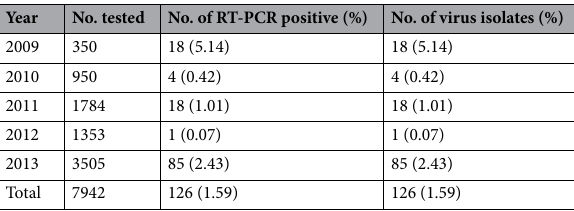
Table 1. Isolation rates of AIVs from wild migratory bird fecal samples in South Korea, winter 2009 ‒ 2013. Percentages are relative to the total per year.